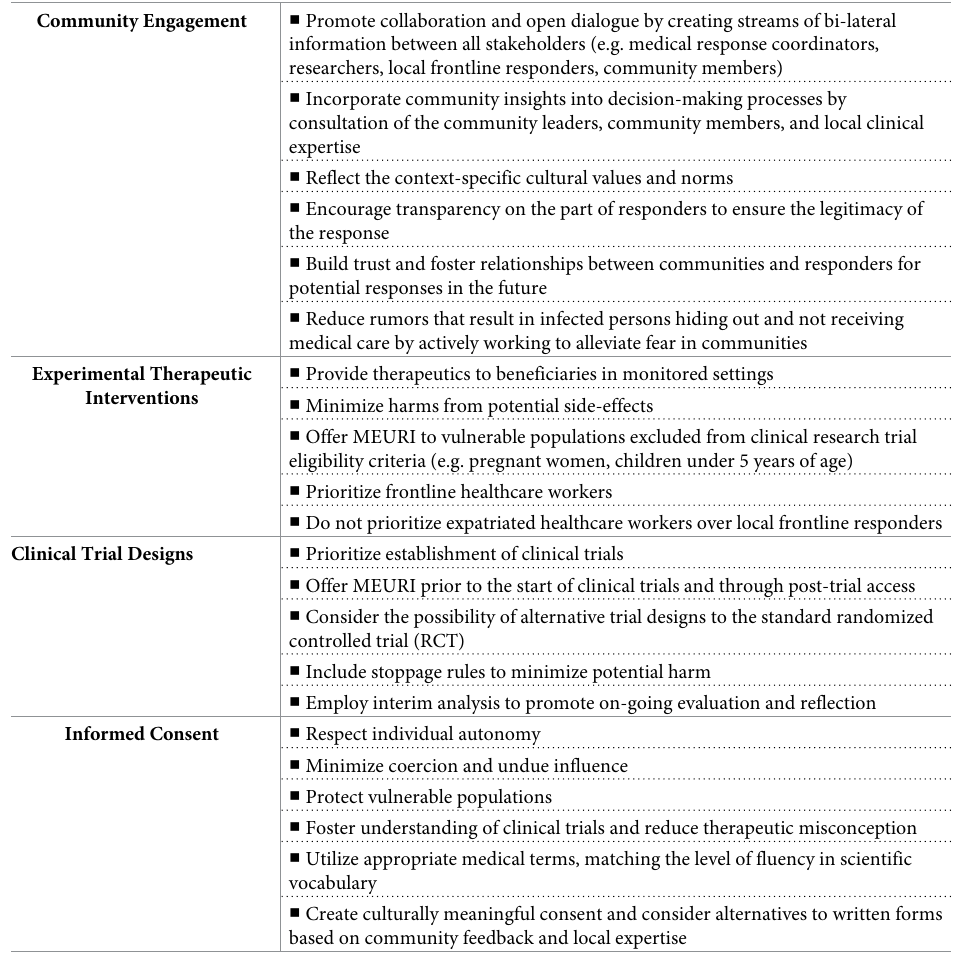
Table 1. Proposed framework of guiding principles for preparedness and implementation by international response organizations for EID outbreaks. Community